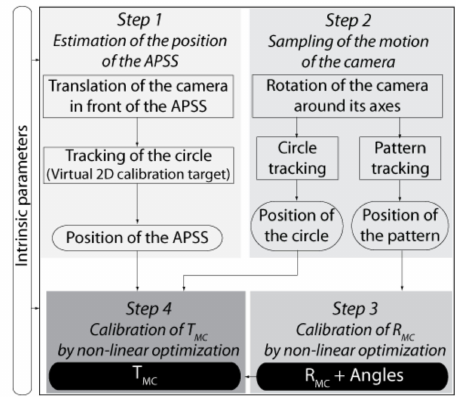
Figure 15. Four-step calibration procedure for the ASP using speckle metrology and the APSS. Step 1 consists of the estimation of the position of the APSS in the reference frame of the camera. Step 2 consists of sampling the motion of the camera by rotating it (one axis at a time) in front of the APSS and recording the images of the speckle circle and speckle pattern at several angular positions. Calibration of the rotation component of transform E MC is performed at Step 3 by optimizing the parameters of the transform for minimizing the reprojection error of the circle and pattern on the image plane of the camera. The translation component of E MC is estimated at Step 4, again by non-linear